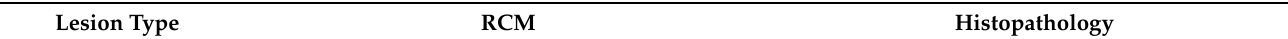
Table 1. RCM and histological features of multinucleate cell angiohistiocytoma and its